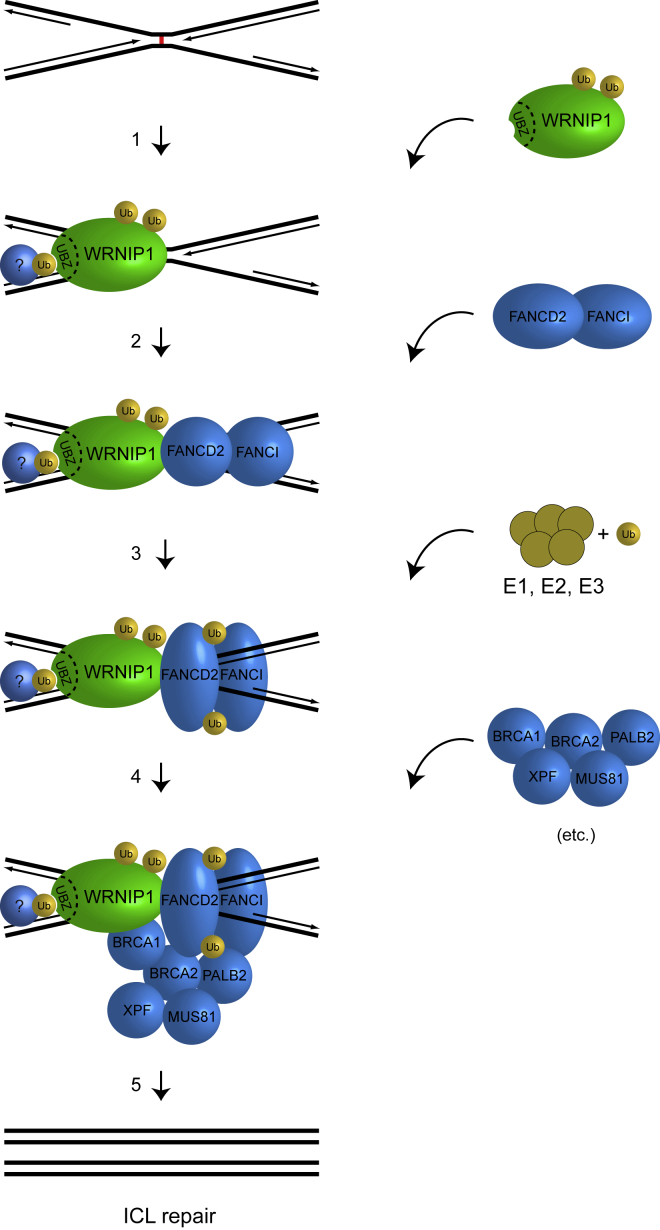
Model Showing How WRNIP1 Functions in ICL Repair(1) WRNIP1 is recruited to an ICL in the chromatin, potentially assisted by a hypothetical protein that is ubiquitinated. (2) The FANCD2/FANCI complex is recruited, causing a conformational change upon interaction with DNA. (3) The FANCD2/FANCI complex is monoubiquitinated, causing another conformational change that leads to its ring-like structure encircling the DNA helix. (4) Additional ICL repair factors are recruited. (5) The ICL is repaired.